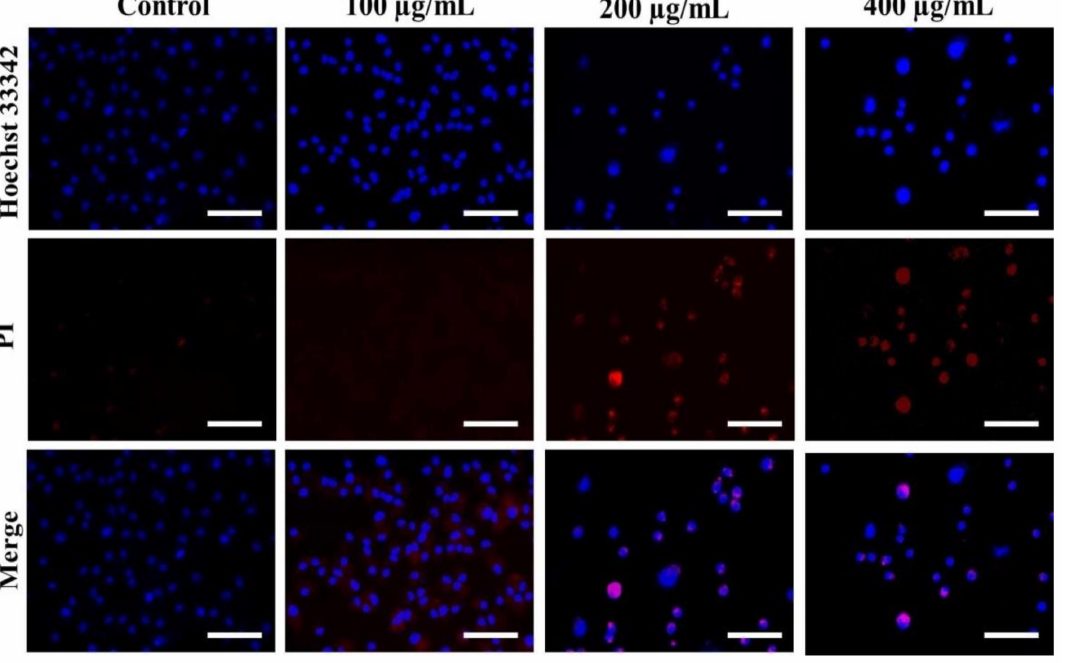
Figure 4. Evaluation of apoptosis instigated by varying concentrations of AvL -EtOH within A549 cells. Fluorescent photomicrographs exhibiting augmented levels of nuclear fragmentation and apoptosis within AvL -EtOH (100, 200 and 400 µ g/mL)-treated A549 cells. Scale bar = 100 µ